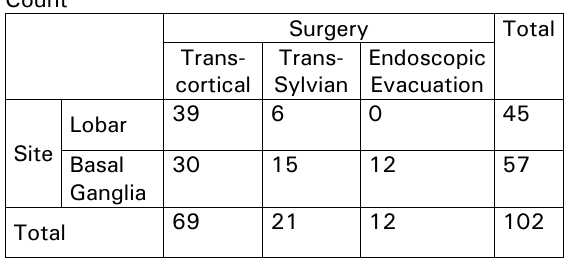
Table 1: Site of hematoma and